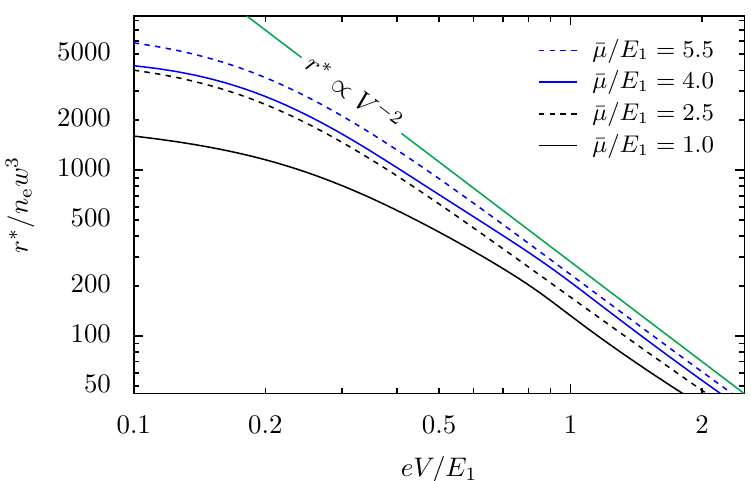
Figure 5: Estimate of the distance r ∗ at the right of the QPC where the maximum power dissipation occurs, as a function of the bias voltage V . The distances are P R w 3 , where n given in units of n is the electron density of the 2DEG and 2 w is the e e width of the QPC, while the energies are scaled with the one of the first transverse mode of the QPC. Solid lines are for values of ¯ µ in a conductance step, dashed lines on plateaus. The green line indicates the slope of a power law r ∗ ∝ V − 2 . The = T / E temperature is given by k B 1